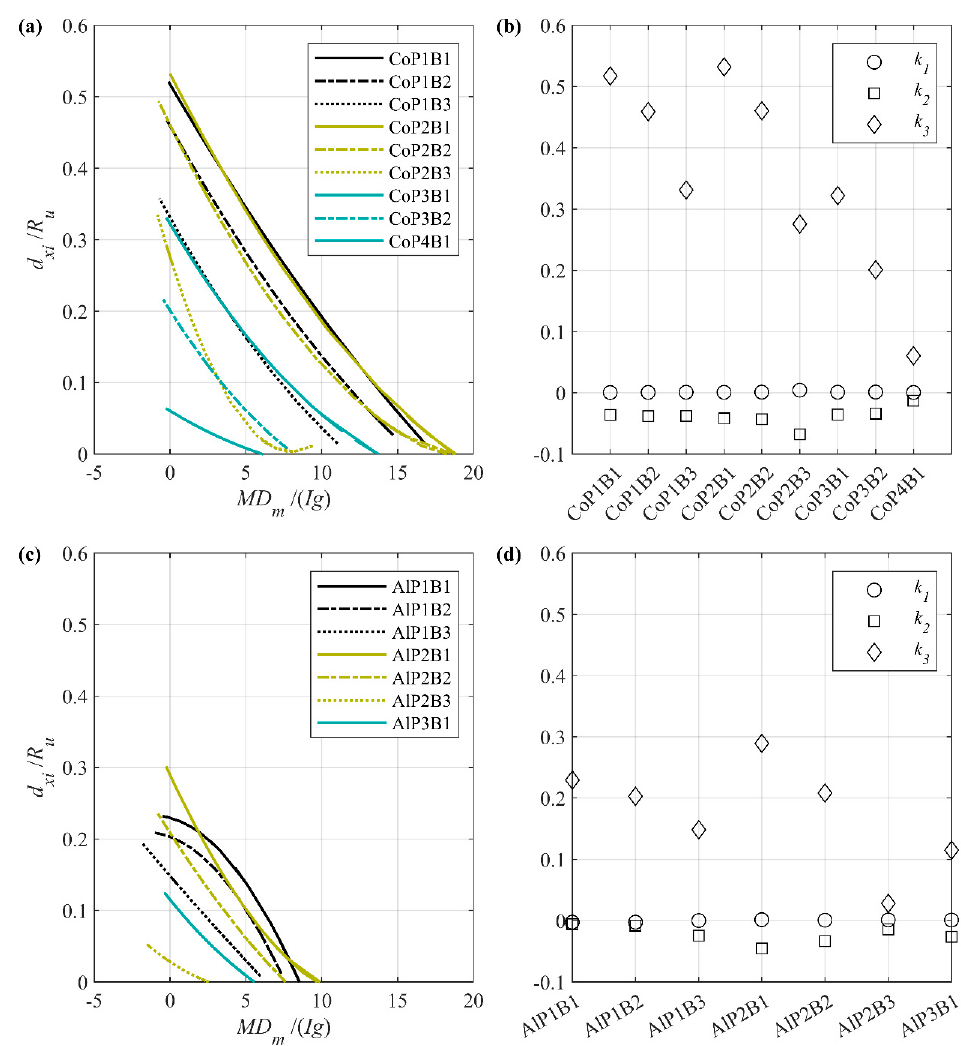
Figure 8. Uprush cross-shore distance travelled—moment relationship and coefficients. Lines correspond to Equation (24) fitted for each averaged event for objects with concrete ( a ) and aluminum ( c ) densities. Markers indicate the coefficients k 1 , k 2 , and k 3 , of Equation (24) varying as a function of the scenario and for objects with concrete ( b ) and aluminum ( d ) densities.